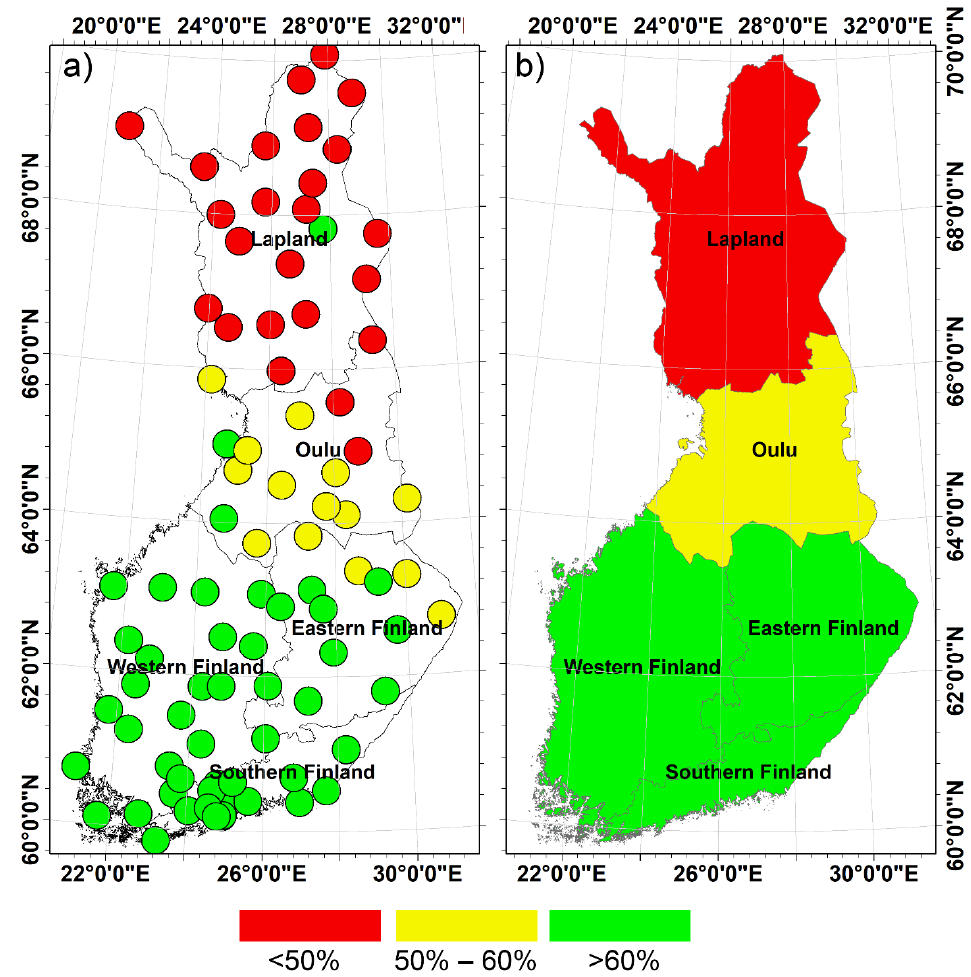
Figure 6. Spatial coverage of satellite estimates: ( a ) rain-gauge stations and ( b ) regional scale.